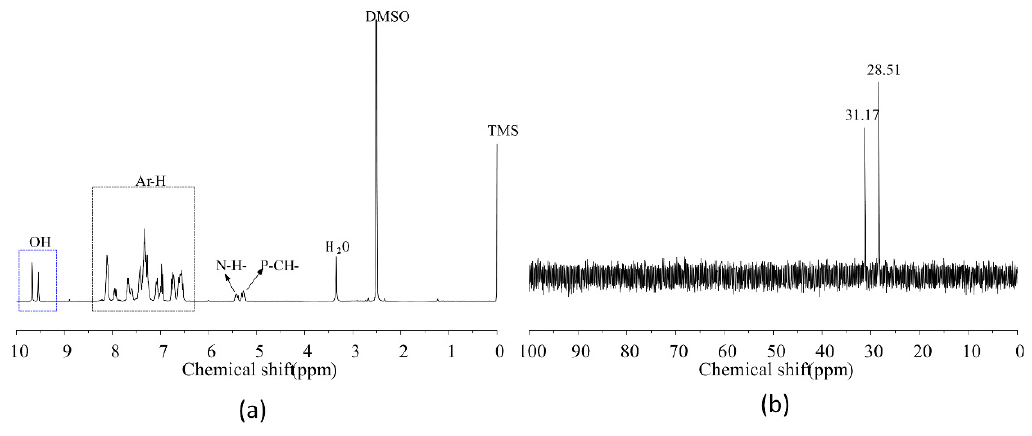
Figure 2. 1 H-NMR ( a ) and 31 P-NMR( b ) spectra of DSD.